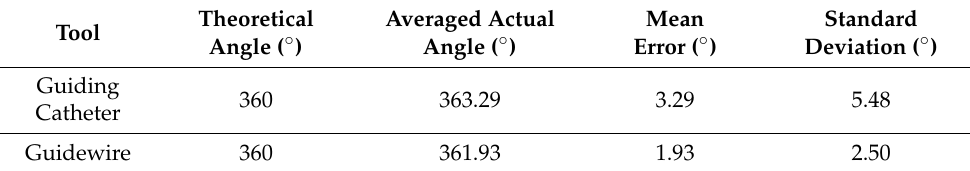
Table 2. Accuracy and precision of rotational motion of vascular instruments.